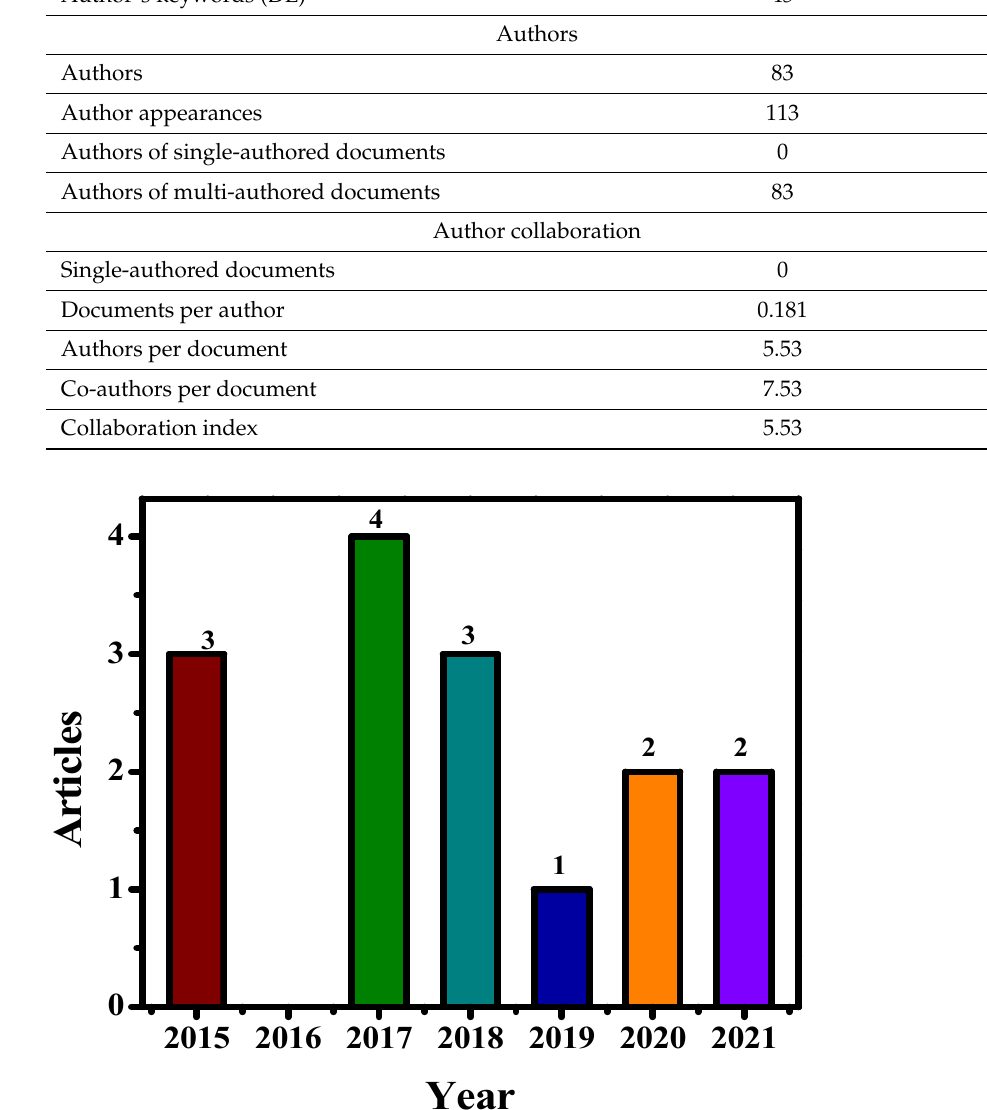
Figure 7. Publications per year of non-polar GaN-based photodetectors.